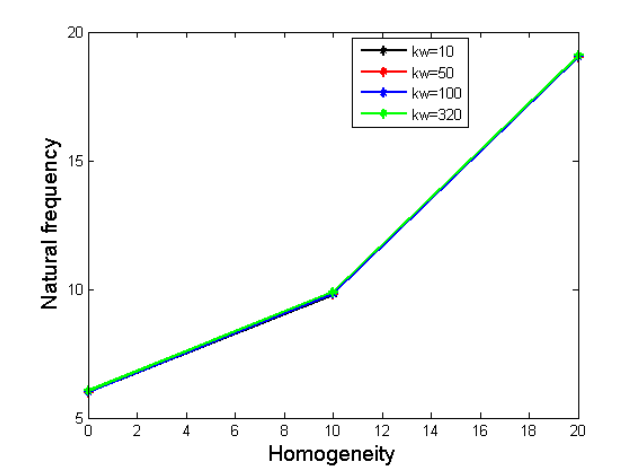
Figure 4. Influence of homogeneity on natural frequency clamped edge condition